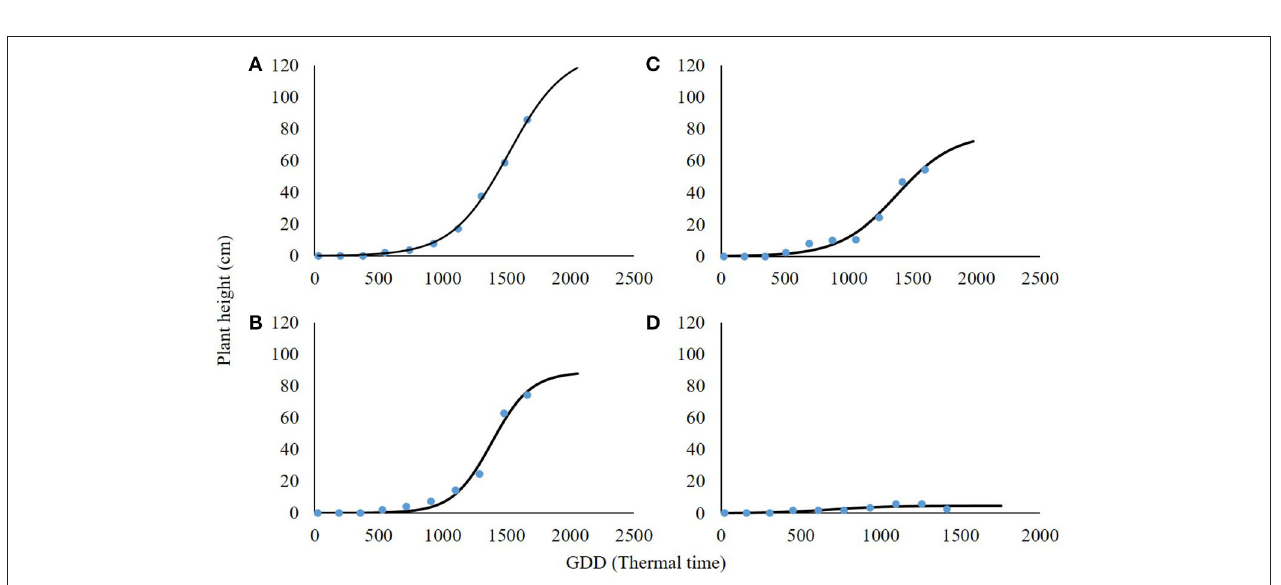
FIGURE 6 | Effect of shade levels (0, 30, 60, and 90%; A–D , respectively) on final plant height of Parthenium hysterophorus . The coefficient for non-linear regressions is given in Table 4